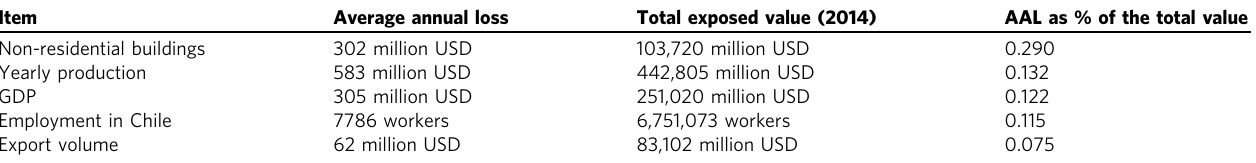
Table 1 Aggregated results of losses at the national